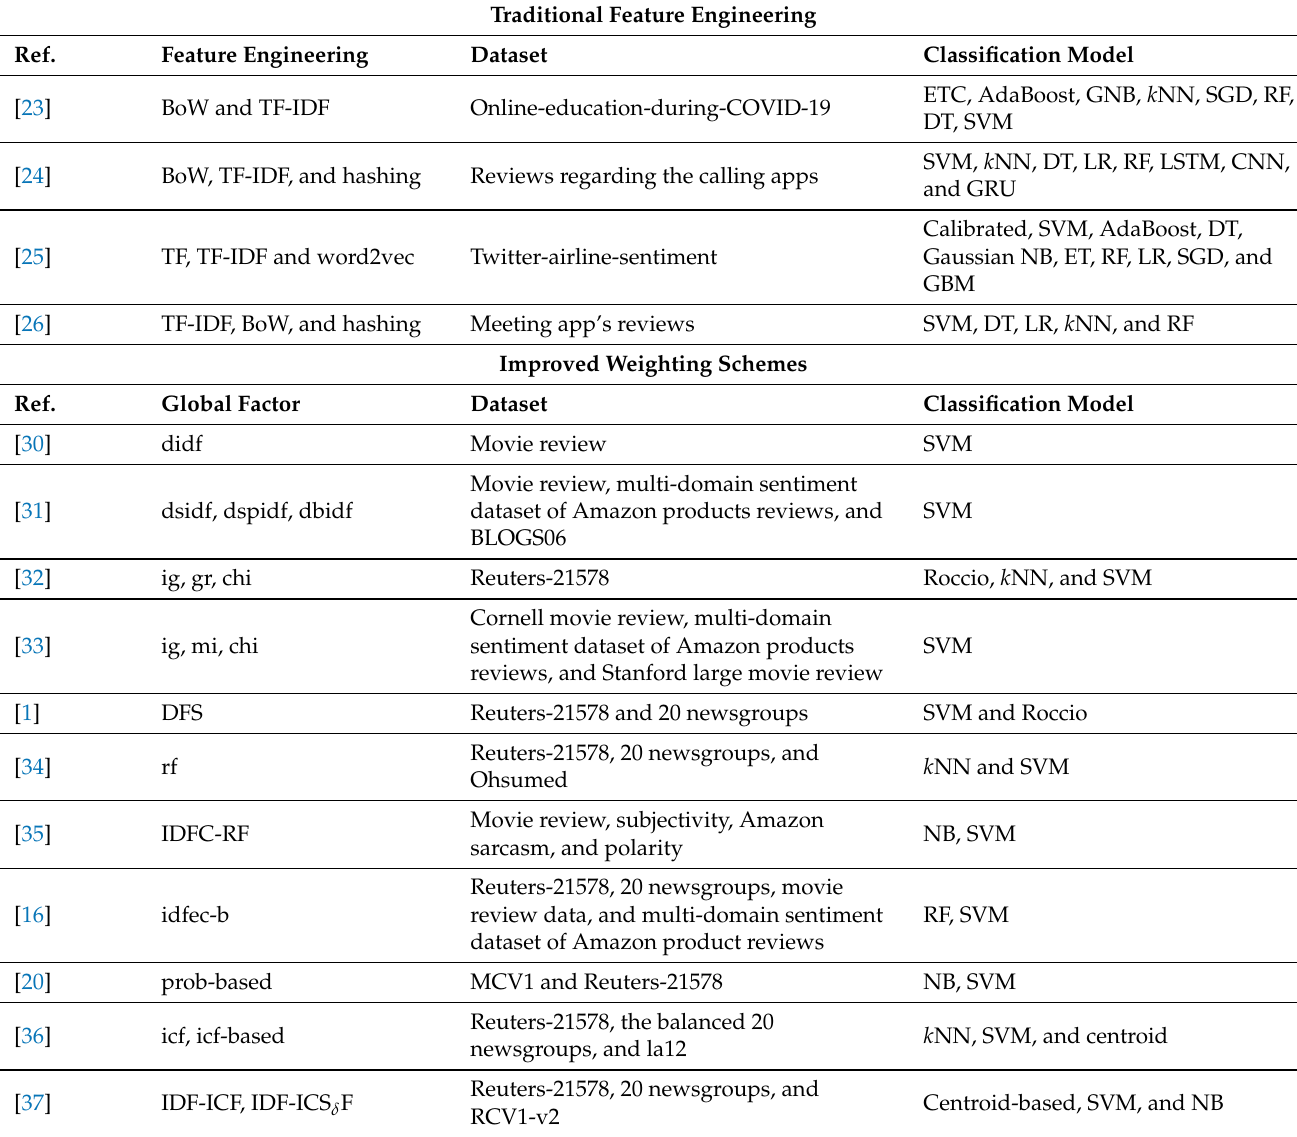
Table 3. Related works